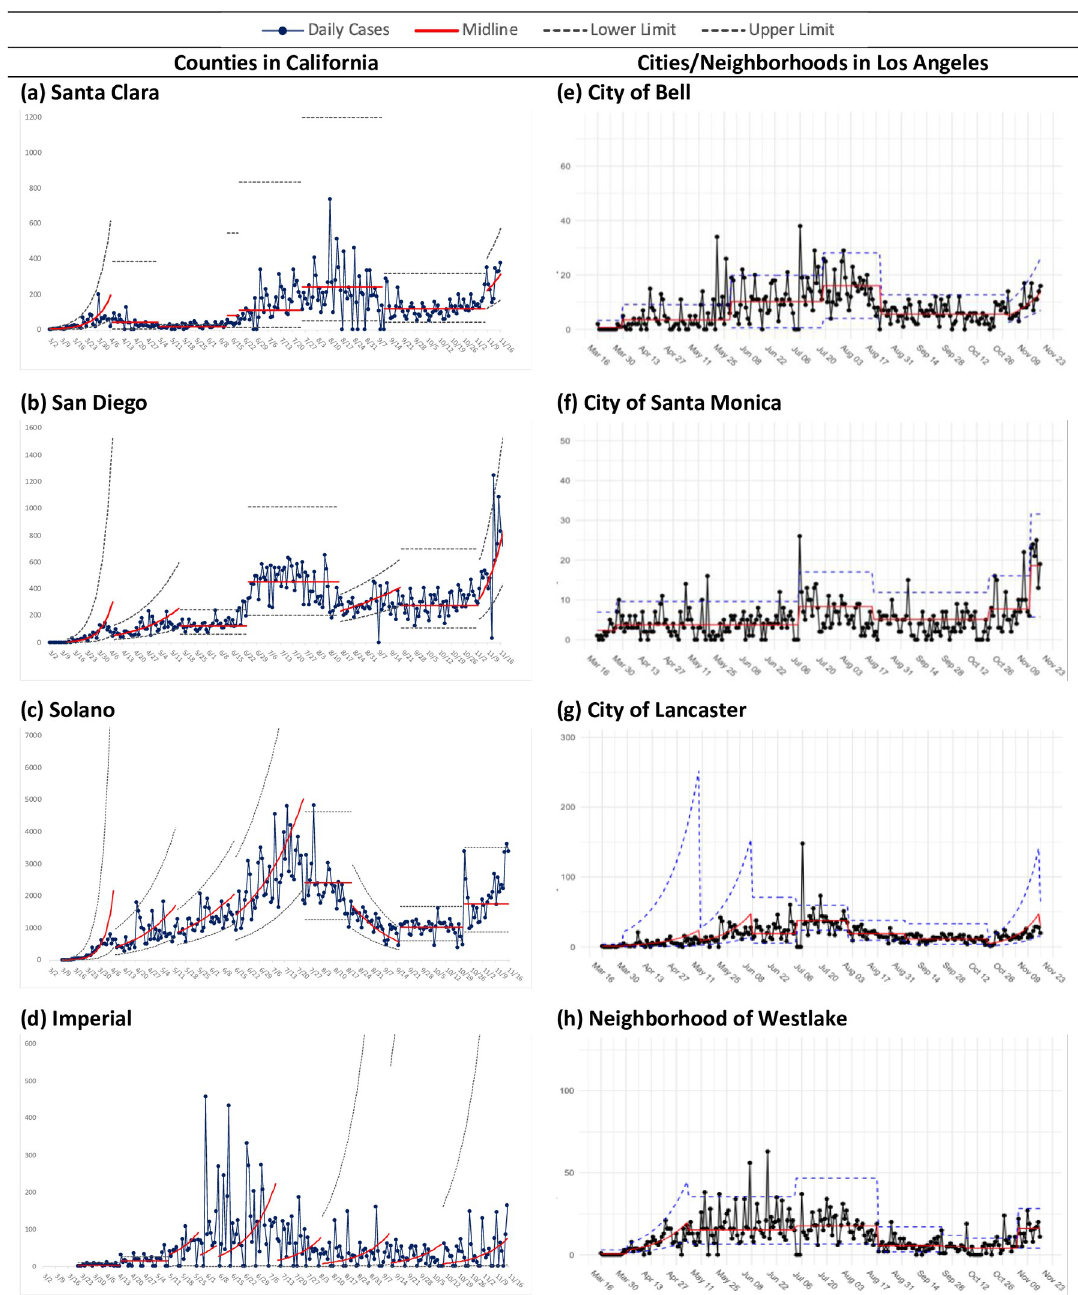
Fig 1. Control charts of COVI D-19 cases: California, counties, subregions. Shows daily case counts, midline, and upper and lower control limits. Source for county data is the New York Times. Source for Los Angeles cities/neighborhoods is the Department of Public Health COVID-19 dashboard (accessed 1/10/2020).